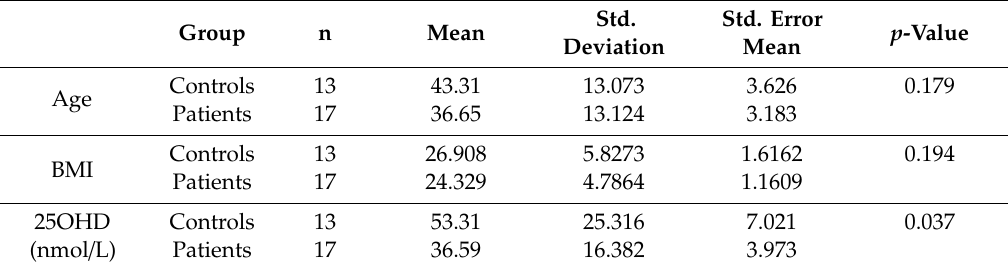
Table 6. Sub-group analysis for